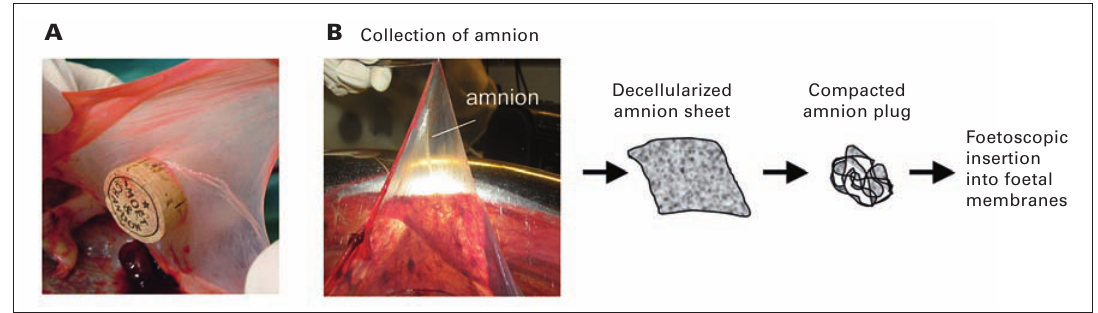
Plugging foetoscopic access sites in foetal membranes with scaffolds. (A) The prophylactic plugging approach, here illus- trated with a champagne cork inserted into a large foetal membrane defect, aims to create a physical barrier to amniotic fluid. (B) Deployment of plugs made of decellularized human amnion is a potential practical surgical method to seal foetoscopic access sites [15, 32]. Human amnion is a readily accessible, unique source of human collagen matrix. The 0.2 mm thin, blood vessel-free amnion is an ideal tissue for decellularisation which renders human amnion non-immunogenic. The decellularised amnion sheet is inserted as a compacted plug that self-locks in the foetal membrane wound.